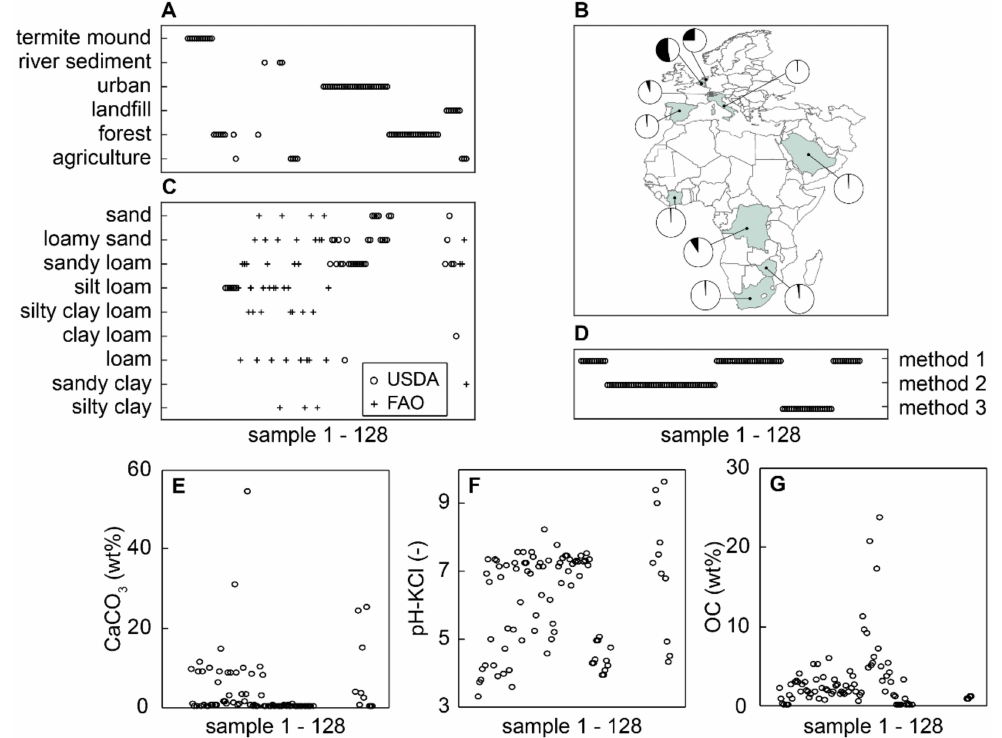
Figure 1. Soil sample database. Overview of land management ( A ), country of origin ( B ), textural class ( C ), laboratory analytical method used ( D ), CaCO3 ( E ), pH-KCl ( F ) and organic carbon (OC) content ( G ) for